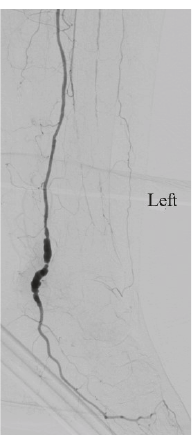
Figure 2: Angiography of the left posterior tibial artery aneurysm after thrombectomy.